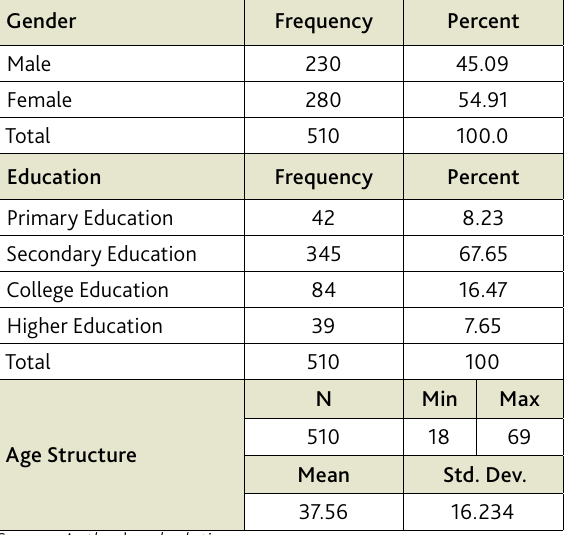
Table 1. Structure of